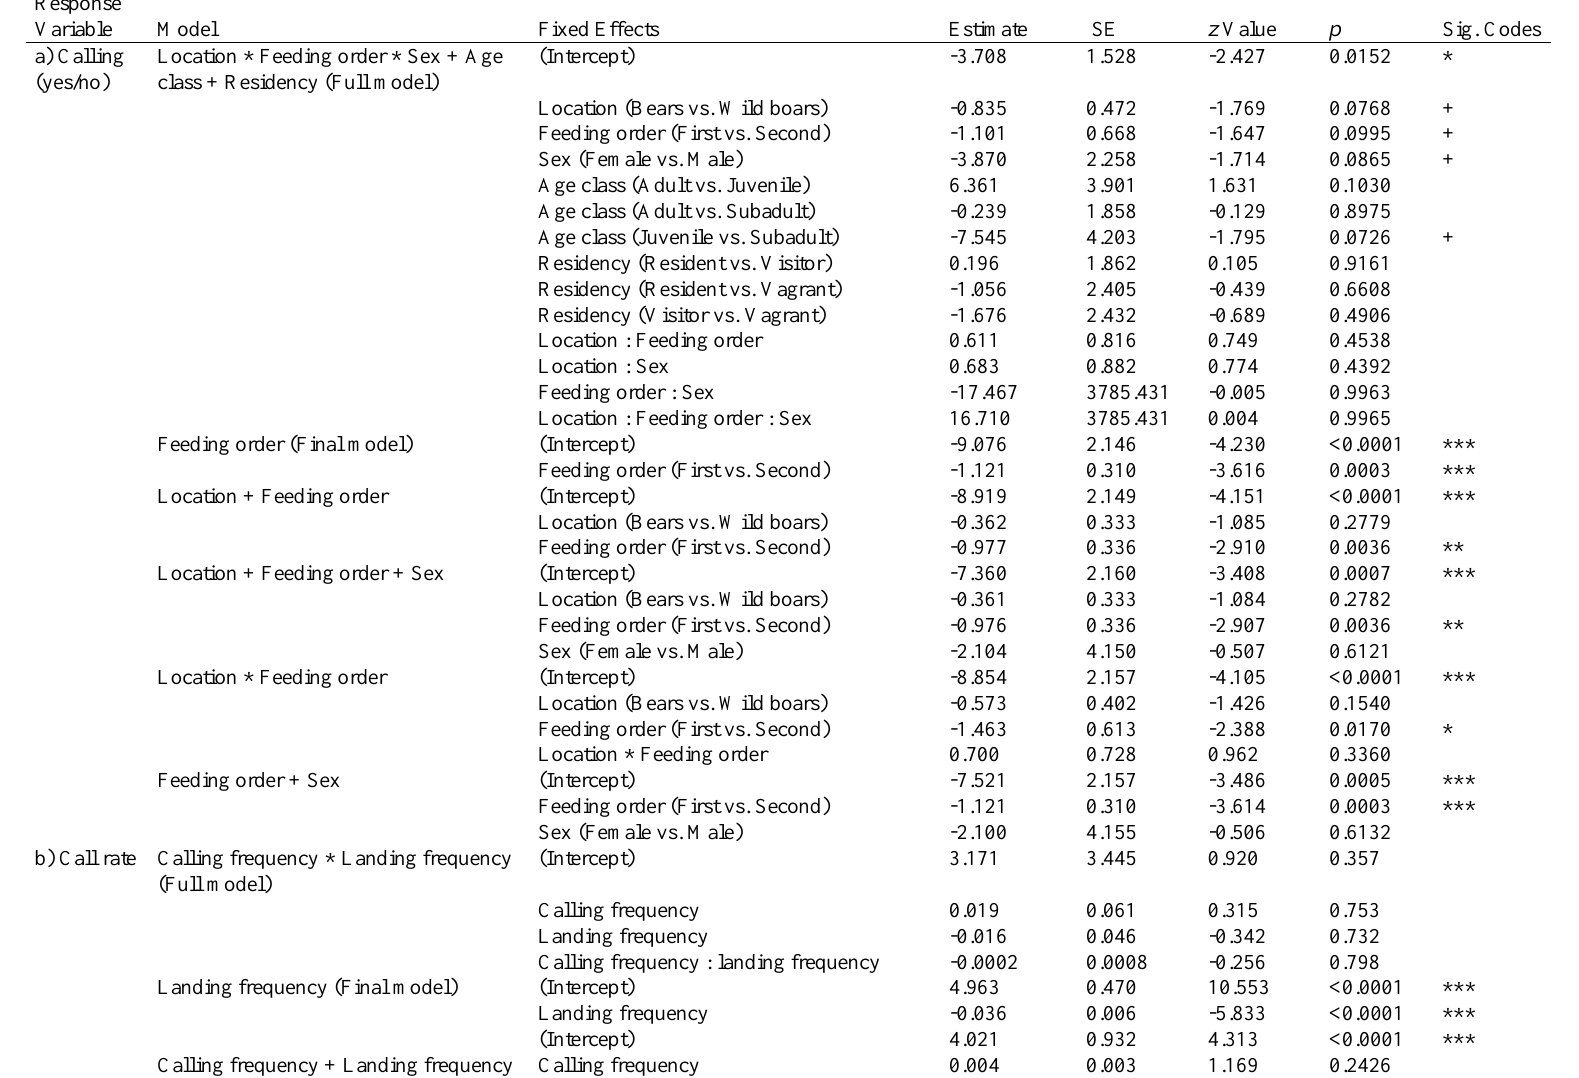
Coefficients of Full and Final Models, and Comparably Best Fitting Models, with Pairwise Comparisons for Levels of Each Fixed Effect in the